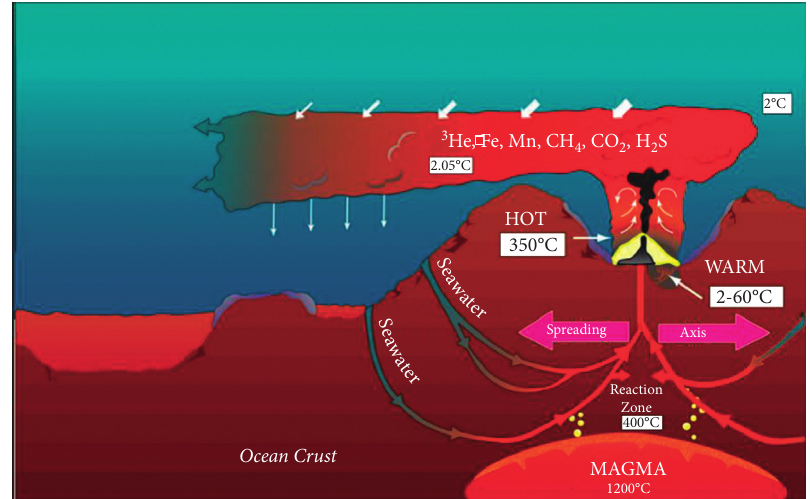
Figure 2: Schematic of hydrothermal activity and hydrothermal plume (figure from Schmidt Ocean